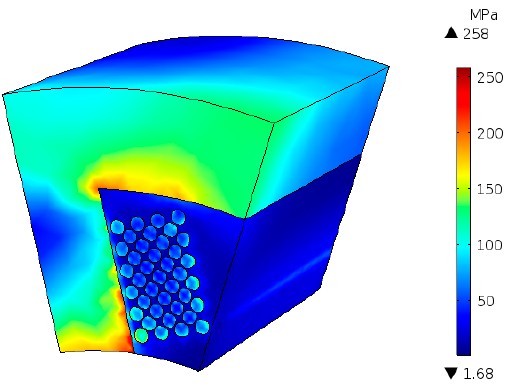
Figure 11. The von-Mises stress distribution over the stator segment for non-uniform temperature distribution.